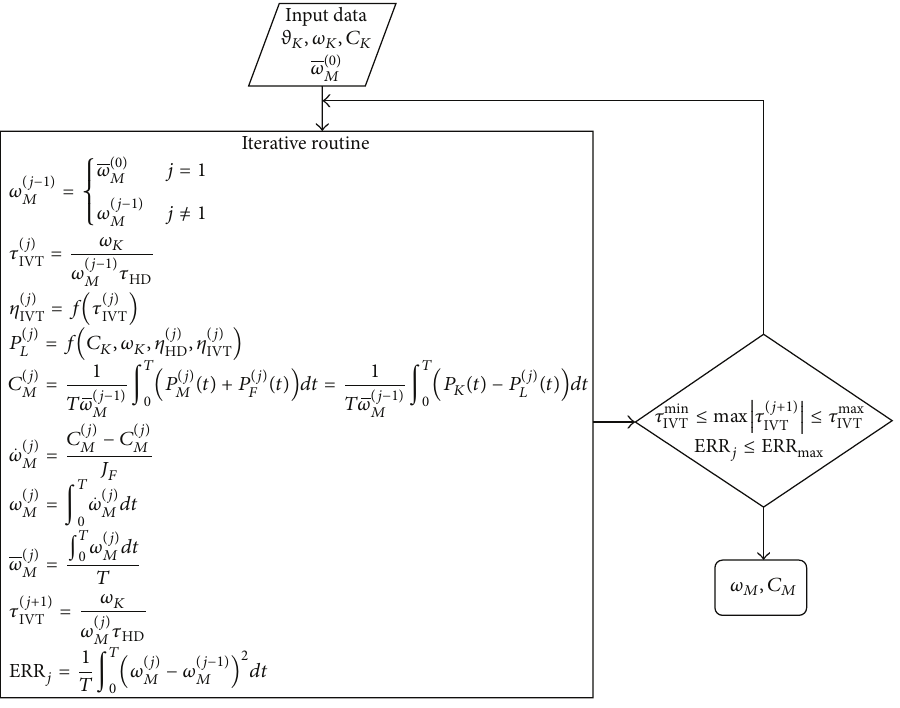
Figure 4: Schematic representation of the iterative routine to solve to calculate the mechanical motor requirements ( 𝜔 𝑀 ,𝐶 𝑀 ).